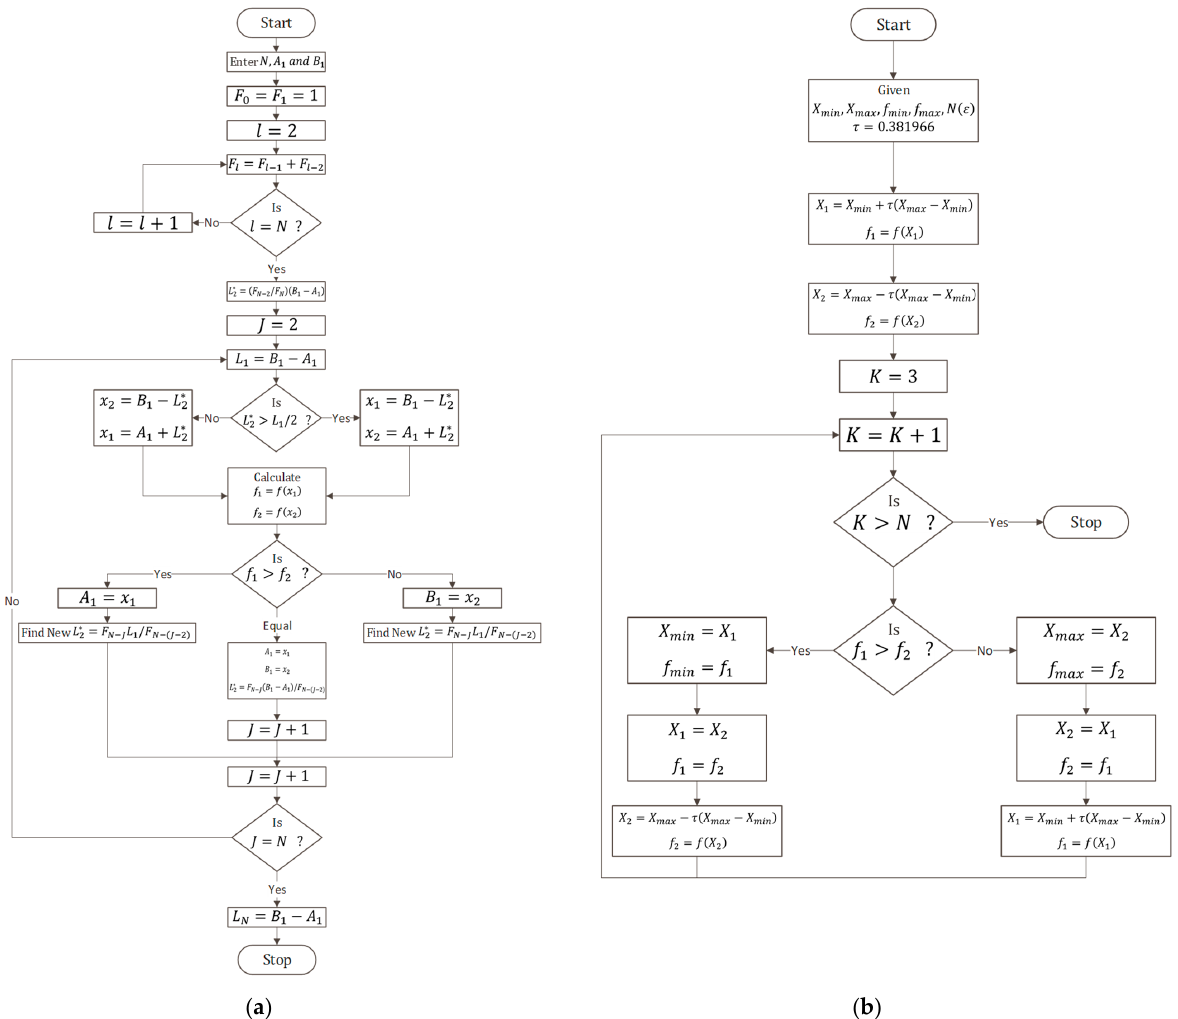
Figure 2. ( a ) Flowchart representation of the Fibonacci optimization algorithm [49] and ( b ) flowchart representation of the golden section optimization algorithm [50].